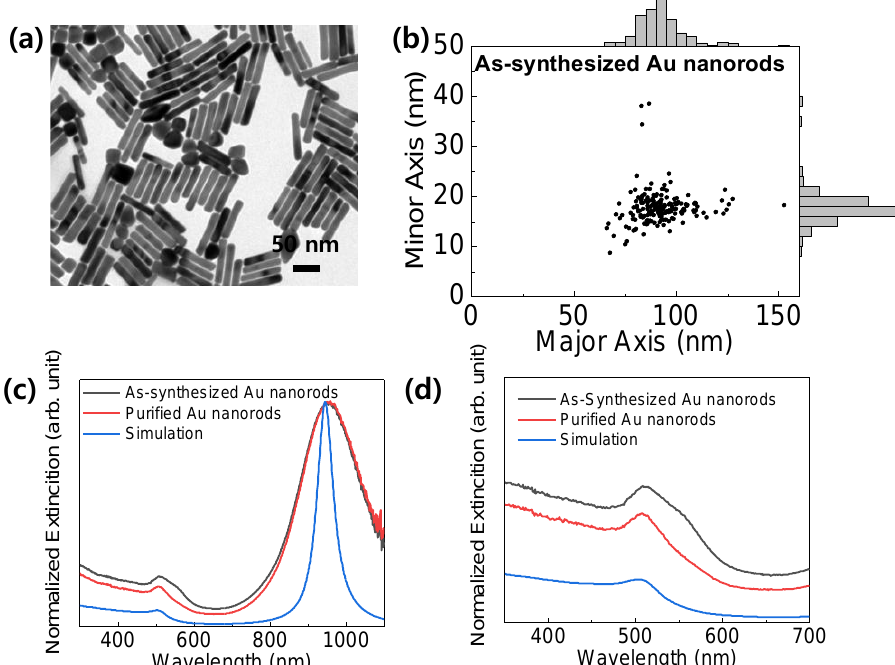
Figure 5. ( a ) TEM image of as-synthesized Au nanorods. ( b ) Size distribution of as-synthesized Au nanorods. ( c ) Extinction spectra of as-synthesized and purified Au nanorods and that obtained via simulation. ( d ) Extinction spectra of as-synthesized and purified Au nanorods and that obtained via simulation attributed as short-axis.